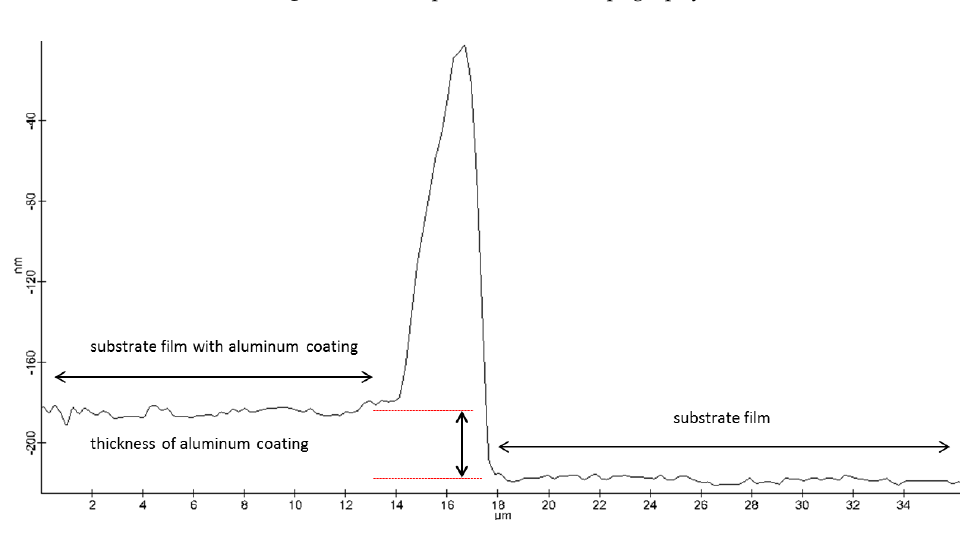
Figure 16. Example of an extracted profile.